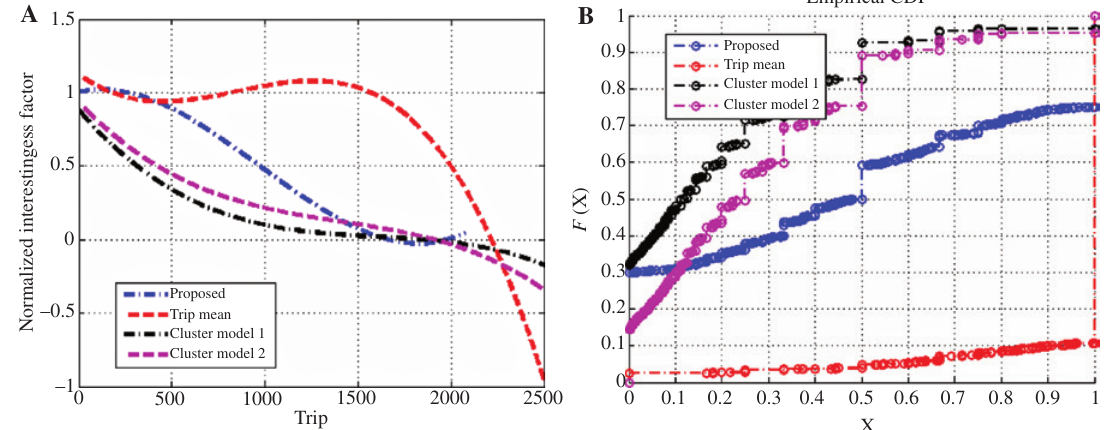
Figure 9: Performance Comparison Using (A) Normalized Interestingness Factor Over Every Trip Plan and (B) Its Distribution for 50% Tolerance.